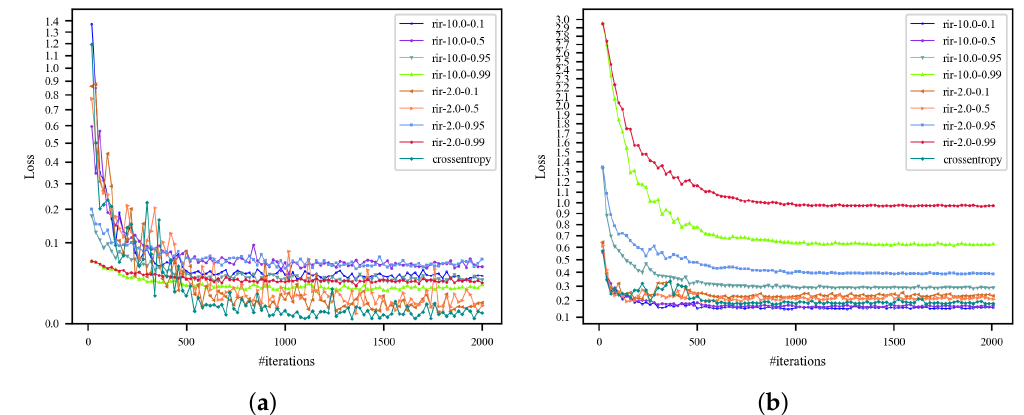
Figure 6. Training and testing loss curves with pre-trained AlexNet on the UC dataset (training ratio = 50%). ( a ) Training loss curves; ( b ) testing loss